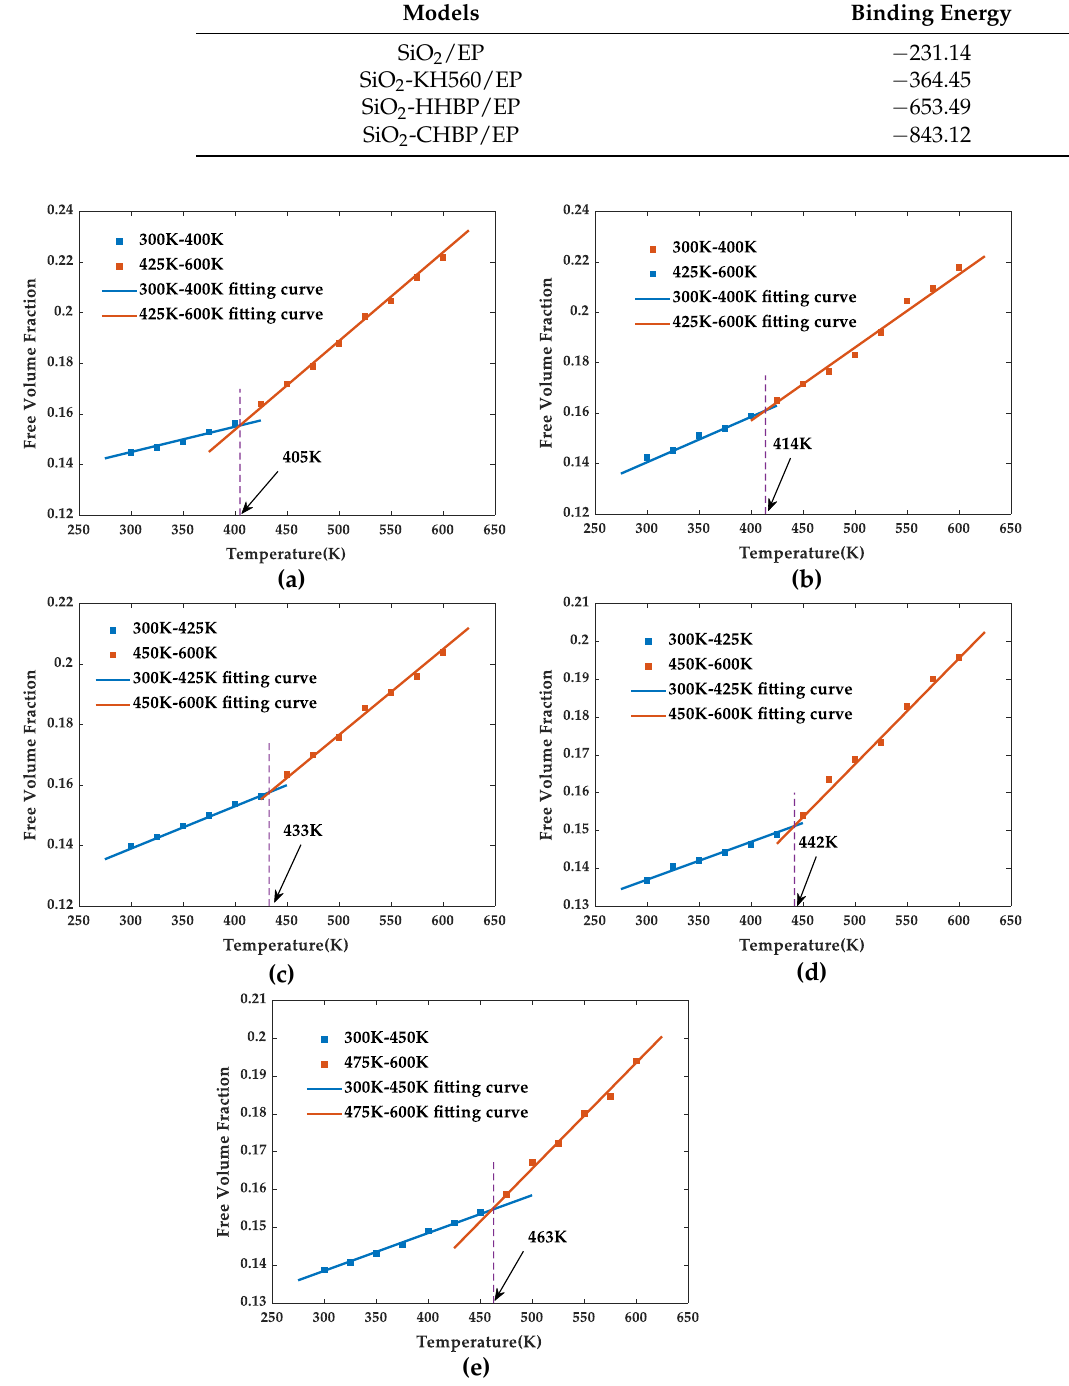
Figure 11. Free volume fractions of five models at different temperatures: ( a ) pure EP model, ( b ) SiO 2 /EP model, ( c ) SiO 2 -KH560/EP model, ( d ) SiO 2 –HHBP/EP model, and ( e ) SiO 2 –CHBP/EP model.